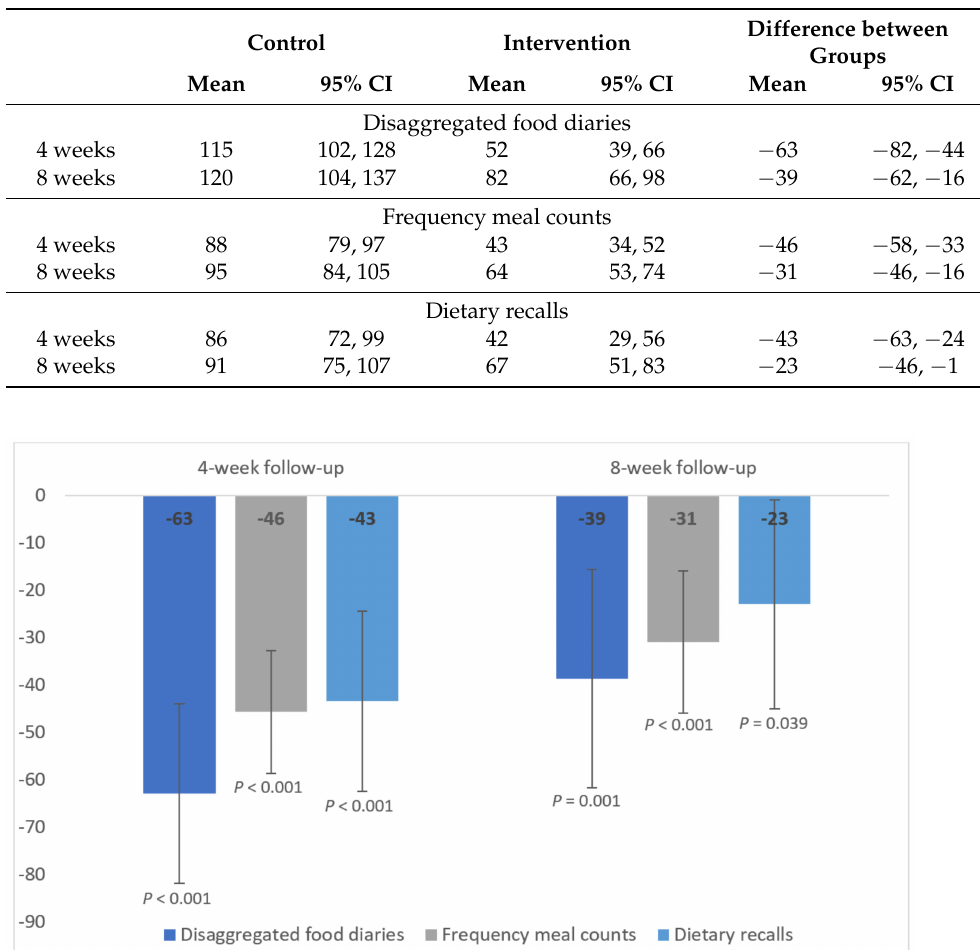
Figure 2. Difference in g/day of total meat consumption relative to control. Mixed-effects models with fixed effects for randomized group, baseline meat consumption and sex, and random effects for participants’ intercept and slope. Values are the mean and 95% confidence intervals. N = 114 at four weeks and N = 113 at eight weeks. Disaggregated food diaries: disaggregating the quantity of meat from meat-containing composite products recorded in 7 day food diaries; frequency meal counts: counting the frequency of meals containing meat recorded in 7 day food diaries*standard portion size; dietary recalls: asking participants to retrospectively recall how many times they consumed meat in the last 7 days through a questionnaire*standard portion